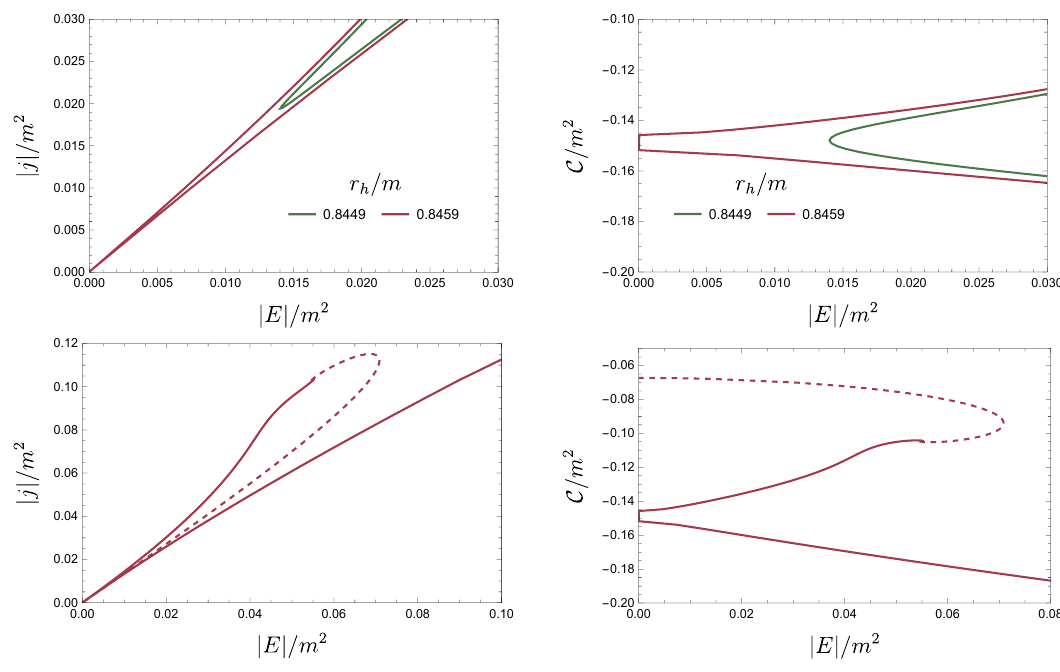
Figure 5 . Electric current and condensate versus electric field for Ω /m = 1 . The continuous lines represent BH embeddings, while the dashed ones are the Minkowski embeddings. The upper plots show that for r h /m around 0.845, we start getting E/m 2 = 0 for BH embeddings. The lower plots are the full curves for the r h /m = 0 . 8459 case. Notice that the electric field increases again, to recover the limit | j | = σ | E |